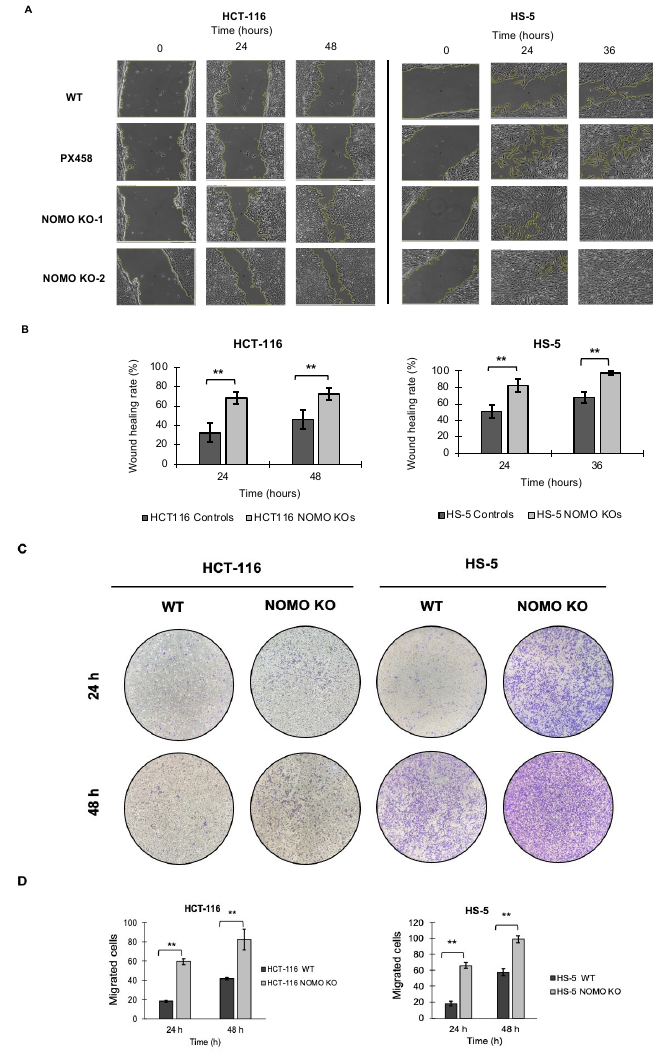
Figure 6. Loss of NOMO1 promotes cell migration of HCT-116 and HS-5 cell lines. ( A ) Wound healing assay of NOMO1-KO and control clones analyzed at 0, 24, and 36 or 48 h. ( B ) Wound healing rate (%) representation for NOMO1-KO and control clones. Data are shown as the mean ± SD of the three replicates. Statistically significant differences are indicated by asterisks (** p < 0.01). ( C ) Transwell assay assessed at 24 and 48 h of NOMO1-KO and control clones. Migrated cells were stained with 1% crystal violet for quantification. ( D ) Quantification of cells with migration capability represented in the Transwell assay as cells migrated to the two cell lines. Data are shown as the mean ± SD. Statistically significant differences are indicated by asterisks (** p <